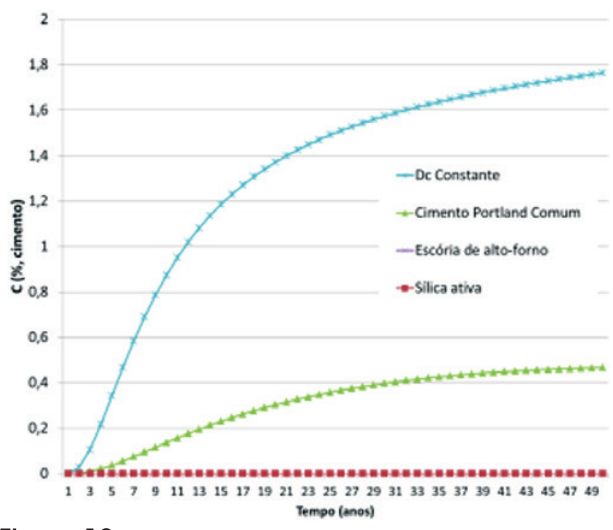
Variação da concentração de cloretos – tempo de